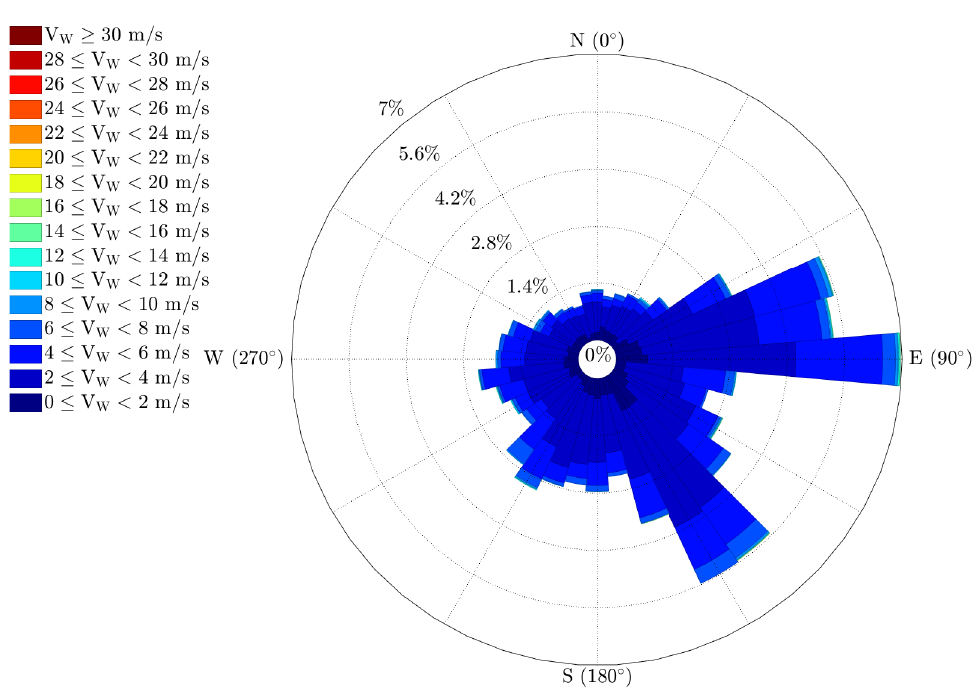
Figure 6. Wind rose diagram for all LLJ events observed at the Braunschweig site at a 40m